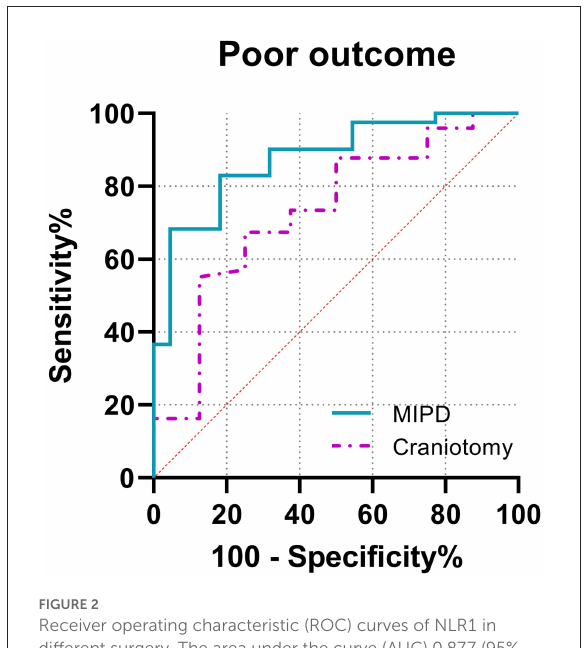
FIGURE2 Receiver operating characteristic (ROC) curves of NLR1 in different surgery. The area under the curve (AUC) 0.877 (95% confidence interval [ CI ], 0.791–0.963; p < 0.0001) for NLR1 in the MIPD group; area under the curve 0.731 (95% CI , 0.539–0.923; p = 0.038) for NLR1 in the craniotomy